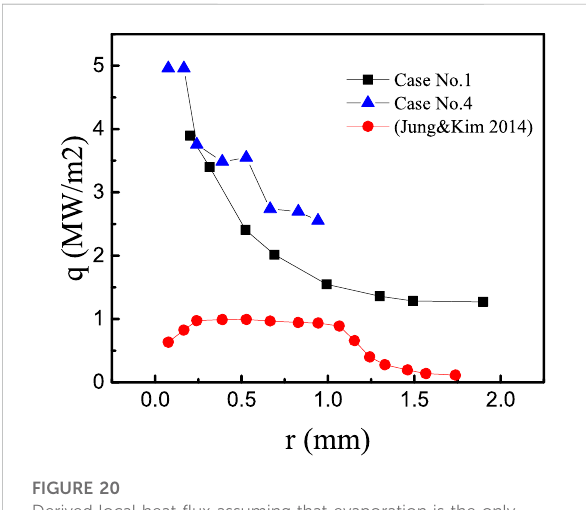
FIGURE 20 Derived local heat fl ux assuming that evaporation is the only mechanism for microlayer depletion.